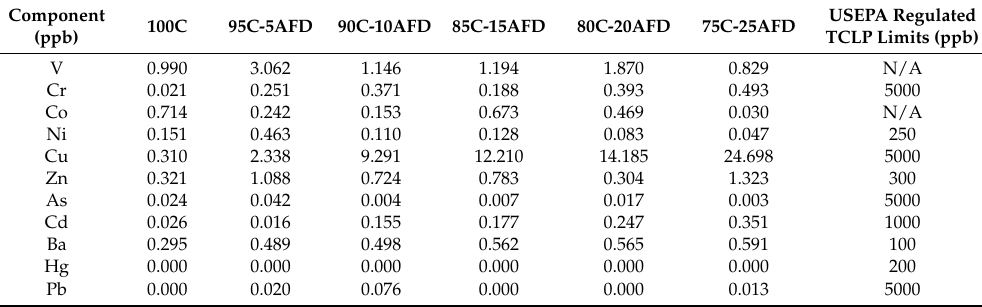
Table 5. Toxicity characteristic leaching procedure (TCLP) leaching test results (ppb) in the fired samples with different AFD contents and the maximum concentration (Environmental Protection Agency (EPA) regulated TCLP limits) of contaminants for toxicity characteristics. Component (ppb)